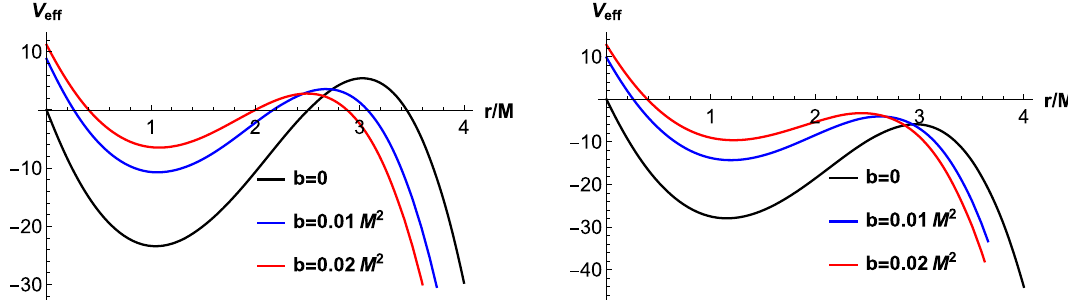
Fig. 12 The left and the right panels describe the effective potential for prograde orbits and the retrograde orbits respectively for various values of b with ˆ a = 0 . 1 M and (cid:2) = 0 . 1